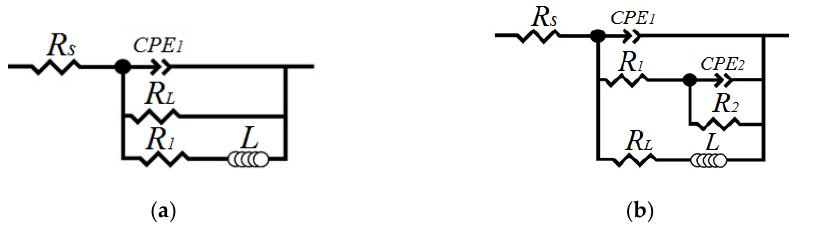
Figure 14. Equivalent electrical circuits used for modelling the impedance spectra for: ( a )—bare Mg0.8Ca alloy, and ( b )—W-coatings. Table 3. Parameters of the EECs